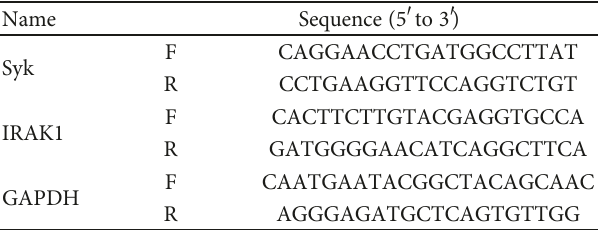
Table 1: Real-time PCR primers used in this study.